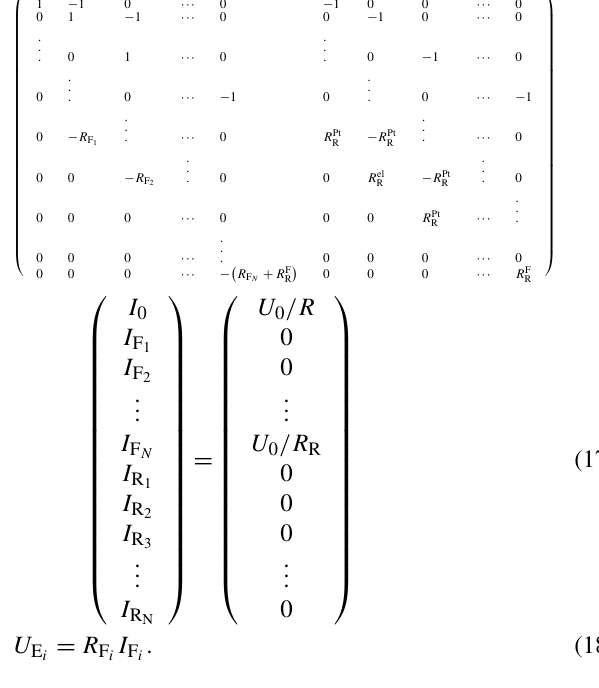
Figure 3. Electrical excitation U E in dependence of the radius r . The Pt electrode radius is